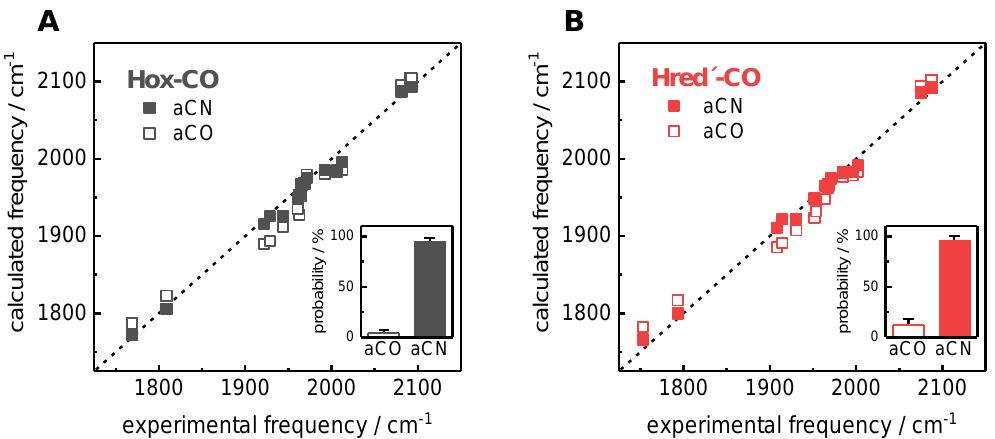
Figure 8. Correlation analysis for Hox-CO and Hred´-CO. The calculated IR frequencies stem from density functional theory (DFT) calculations (corrected for systematic deviations; Equations (1) and (2); Figures S1 and S2, Tables S1–S3). H-cluster structures: apical CO at Fe d (aCO, open symbols), apical CN - at Fe d (aCN, solid symbols). The lines show the diagonal for ideal correlation (( A ), Hox-CO: mean rmsd of 20 cm − 1 for aCO or 8 cm − 1 for aCN. ( B ), Hred´-CO (including a proton at the [4Fe–4S] cluster): mean rmsd of 19 cm − 1 for aCO or 7 cm − 1 for aCN, Table S3). Insets: apparent probability of aCO and aCN structures (Table S4).